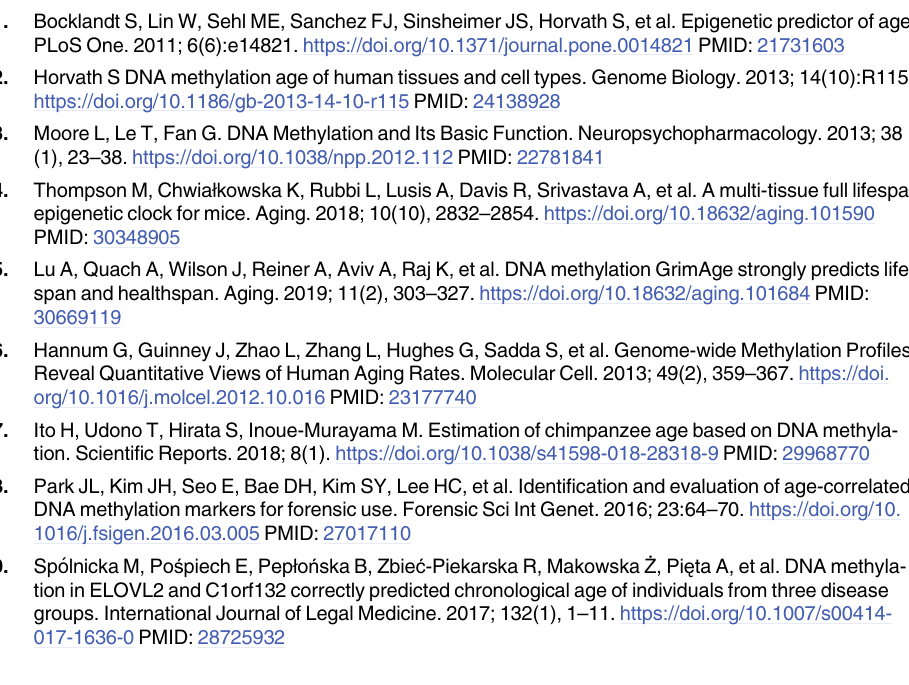
S3 Table. CpGs, and associated genes where available, for all clocks developed using the different feature selection